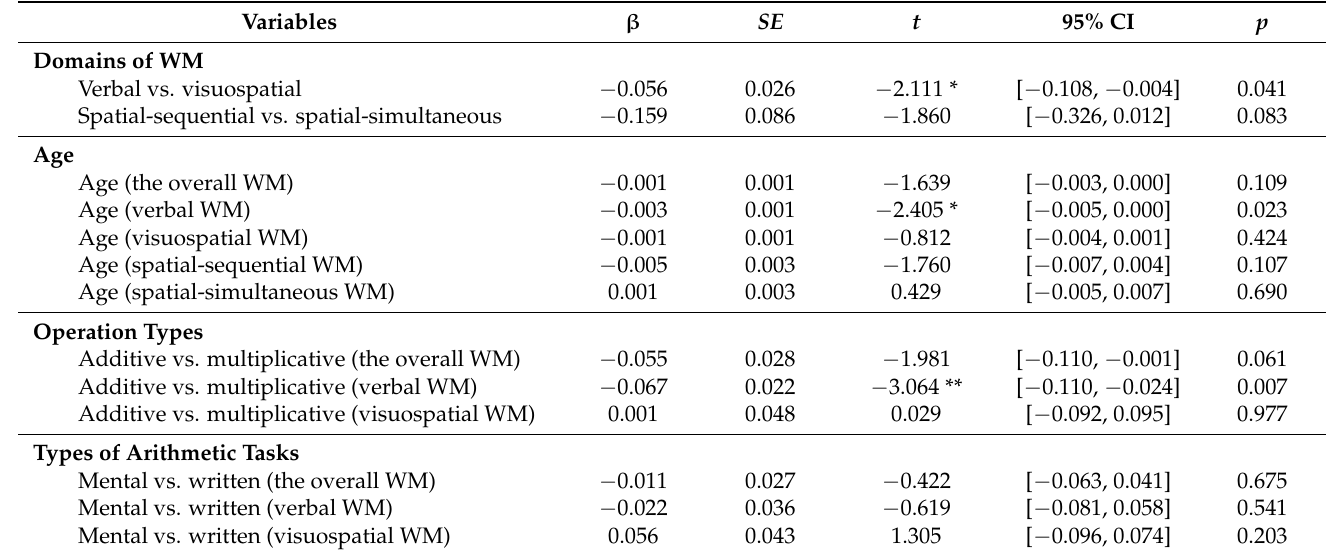
Table 3. Meta-regression on the correlation between working memory and